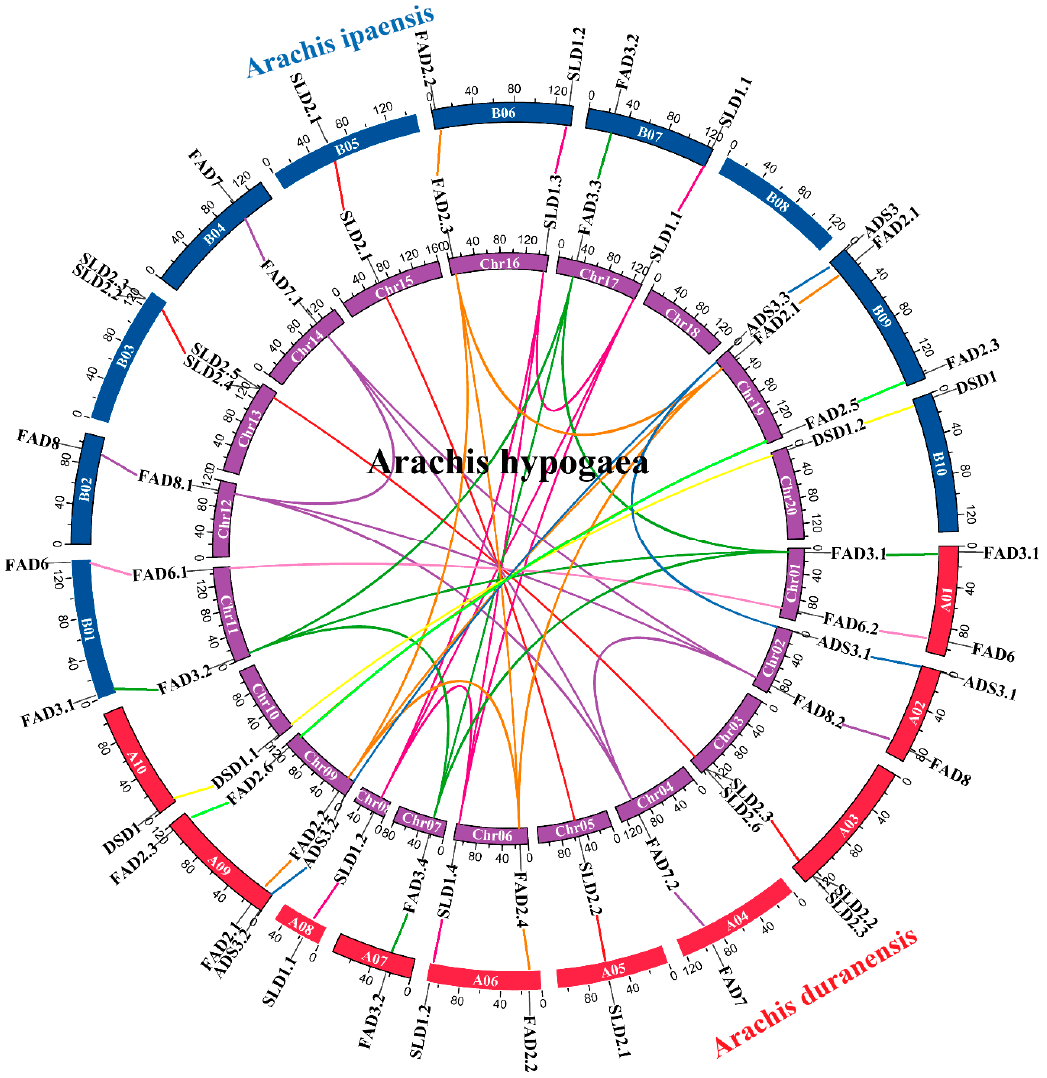
Figure 4. Synteny of FAD genes among Arachis duranensis, Arachis ipaensis, and Arachis hypogaea.